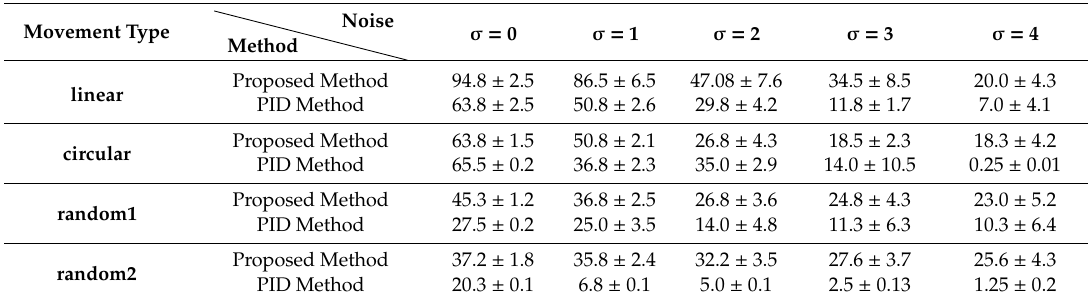
Table A4. Tracking results of UAV in the sensor noise environment. The TSR and data confidence interval are shown in this